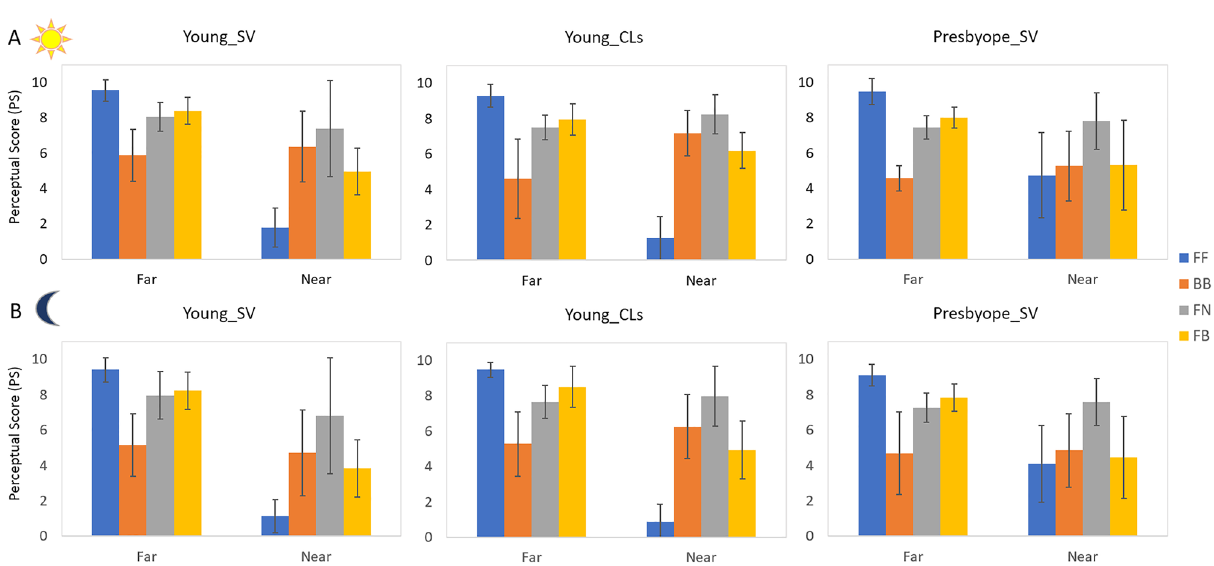
Figure 6. Mean PS across subjects for day ( A , upper row), night ( B , lower row) conditions, at far and near distances.